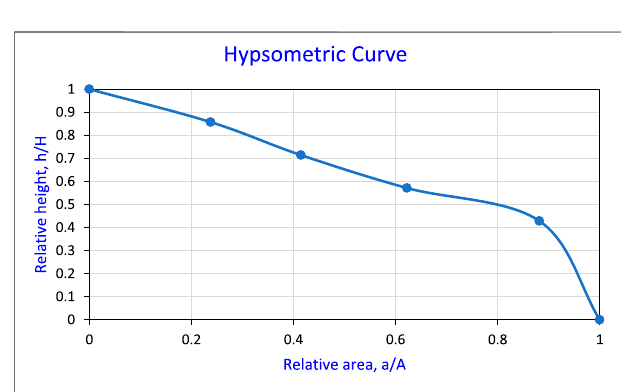
FIGURE 14 | Hypsometric curve of geomorphological revolution in the Vanniyar basin, Dharmapuri district, Tamil Nadu,